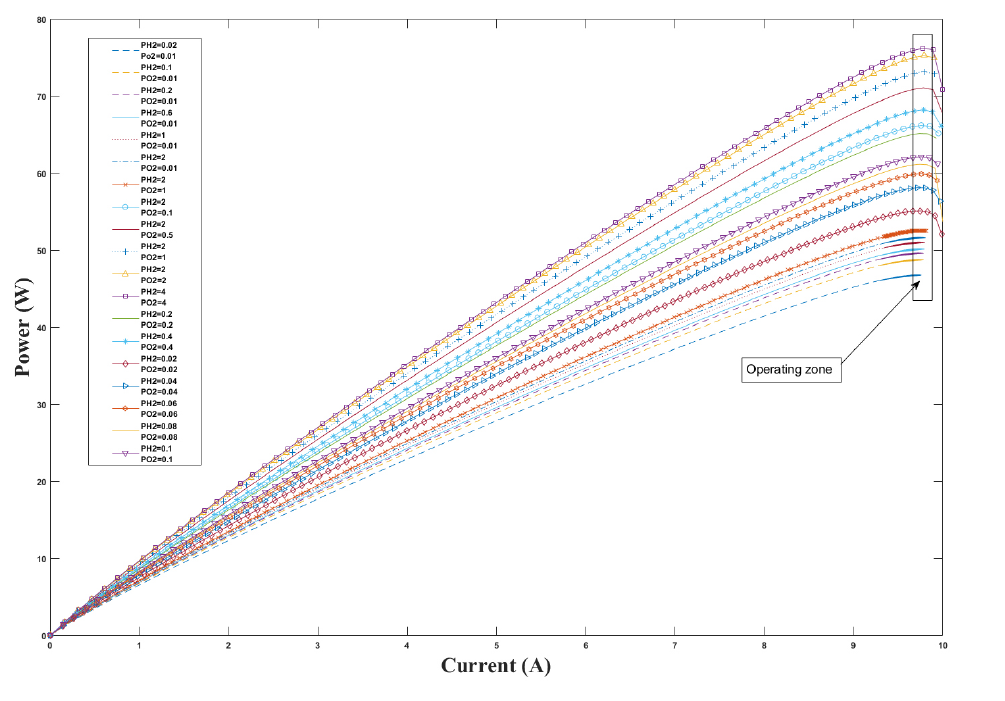
Figure 7. PEMFC polarization curve under different operating temperatures and hydrogen gas pressure.